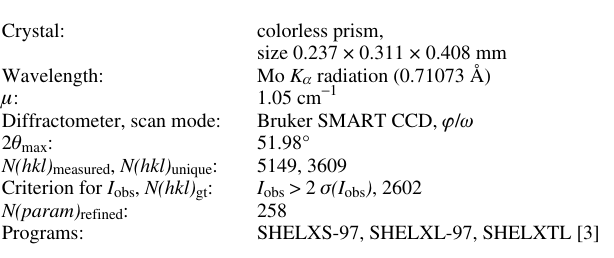
Table 1. Data collection and handling.